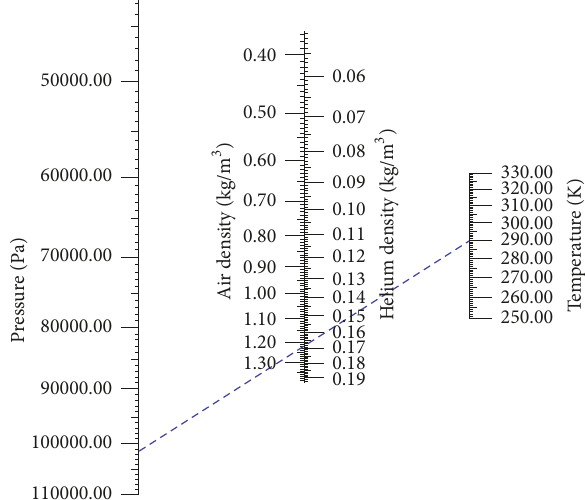
Figure 6: Density-pressure-temperature nomogram and initial inflation determination (dashed line).